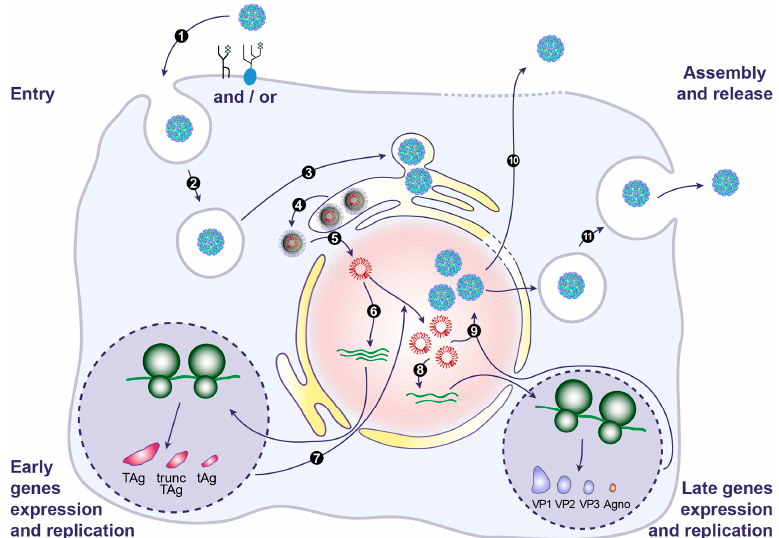
Figure 3. Model of the BKPyV life cycle. BKPyV infection begins with binding of virions to the ganglioside receptors (particularly GT1b and GD1b) and/or an N-linked glycoprotein containing α (2,3)-linked sialic acid, at the cell surface (1). This is followed by internalization potentially through a caveola-mediated endocytosis step within the first 4 h after adsorption (2). The virus subsequently traffics from the late endosomes to the endoplasmic reticulum (ER), where it arrives approximately 10 h post-infection (3). In the ER, virions benefit from chaperones, disulphide isomerases and reductases to facilitate the partial capsid uncoating. This creates a hydrophobic surface exposing VP2/VP3 that binds to and integrates into the ER membrane, leading to the release of partially uncoated viruses into the cytosol, a process that also involves the ER-associated protein degradation (ERAD) machinery (4). The viral genome is then transported into the nucleus via the nuclear pore complex thanks to VP2/VP3 NLS and the importin α / β 1 import pathway (5). Expression of early genes occurs approximately 24 h post-infection (6). Early proteins are translocated into the nucleus where they serve to initiate viral DNA replication (7). Late genes are then expressed (8). VP1, VP2 and VP3 are translocated into the nucleus where they self-assemble to form capsids into which newly synthetized double stranded viral DNA is packaged (9). Progeny virions are mainly released from infected cells after cell lysis (10). However, a small fraction of progeny virions may also be released into the extracellular environment through a non-lytic egress that depends on the cellular secretion pathway